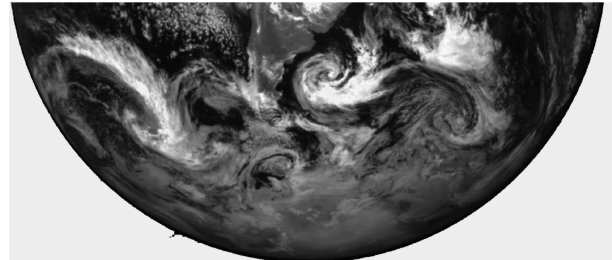
Figure 7. O 2 A-band view of Antarctica on 6 December 2015 show- ing clouds over ice. The bright white clouds are at higher altitudes than the dull grey clouds because of a combination of less oxygen absorption and higher optical